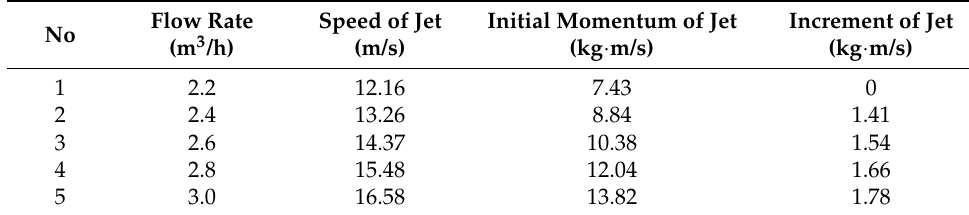
Table 1. The distribution of jet